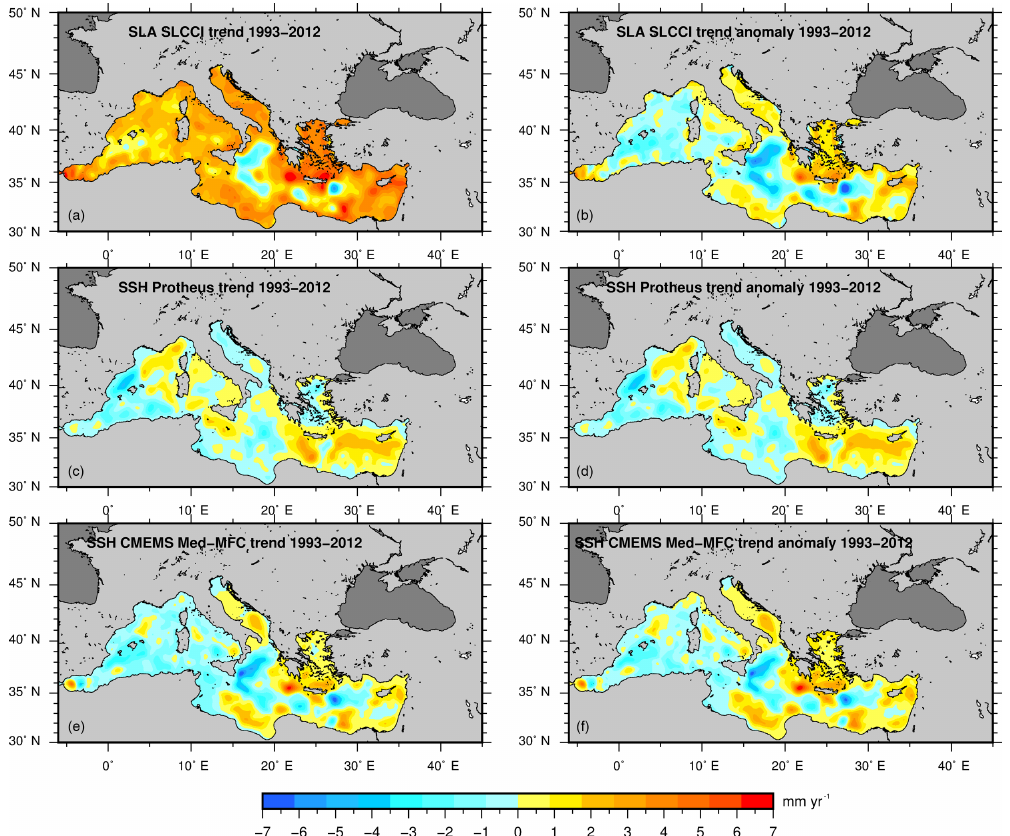
Figure 17. Trend (a, c, e) and trend anomalies (b, d, f) of SSH from SL_cci (a, b) and Protheus model simulation (c, d) and CMEMS reanalysis (e, f)